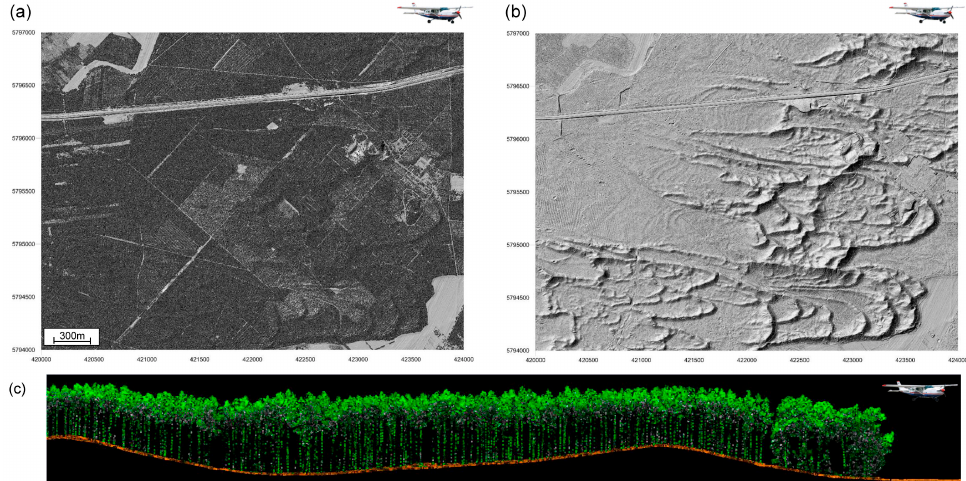
Figure 9. Walking dune near Königs Wusterhausen, southeast of Berlin (Germany) depicted ( a ) as Digital Surface Model (DSM), ( b ) a Digital Elevation Model (DEM) as shaded relief, and ( c ) as a 3D Profile view of the DSM whereby of the dune surface appears orange and the forest vegetation green. The data basis was generated by Airborne Laser Scanning (ALS) with a RIEGL-LiDAR (point density >5 points/m 2 ) carried by airplane.